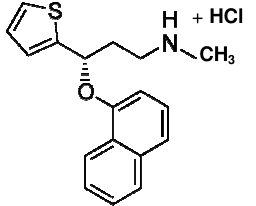
Figure 1 . Chemical structure of duloxetine hydrochloride.